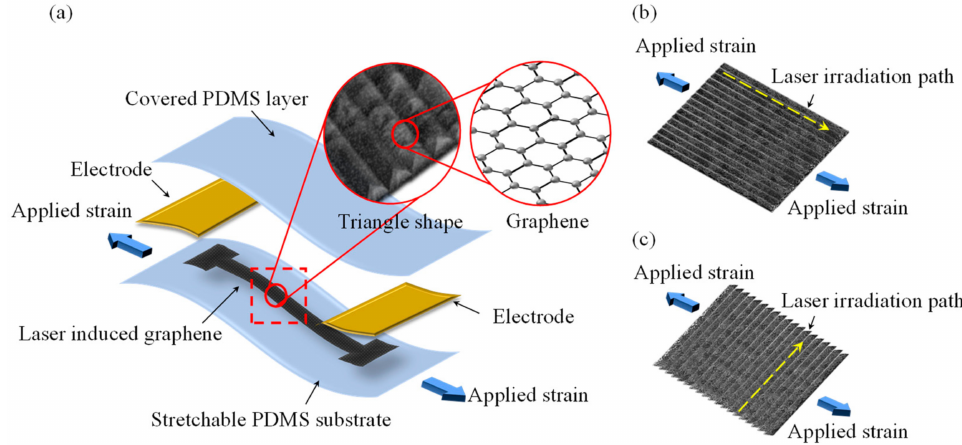
Figure 1. Schematic of the proposed ( a ) stretchable LIG strain sensor, ( b ) parallel LIG structure, and ( c ) vertical LIG structure.